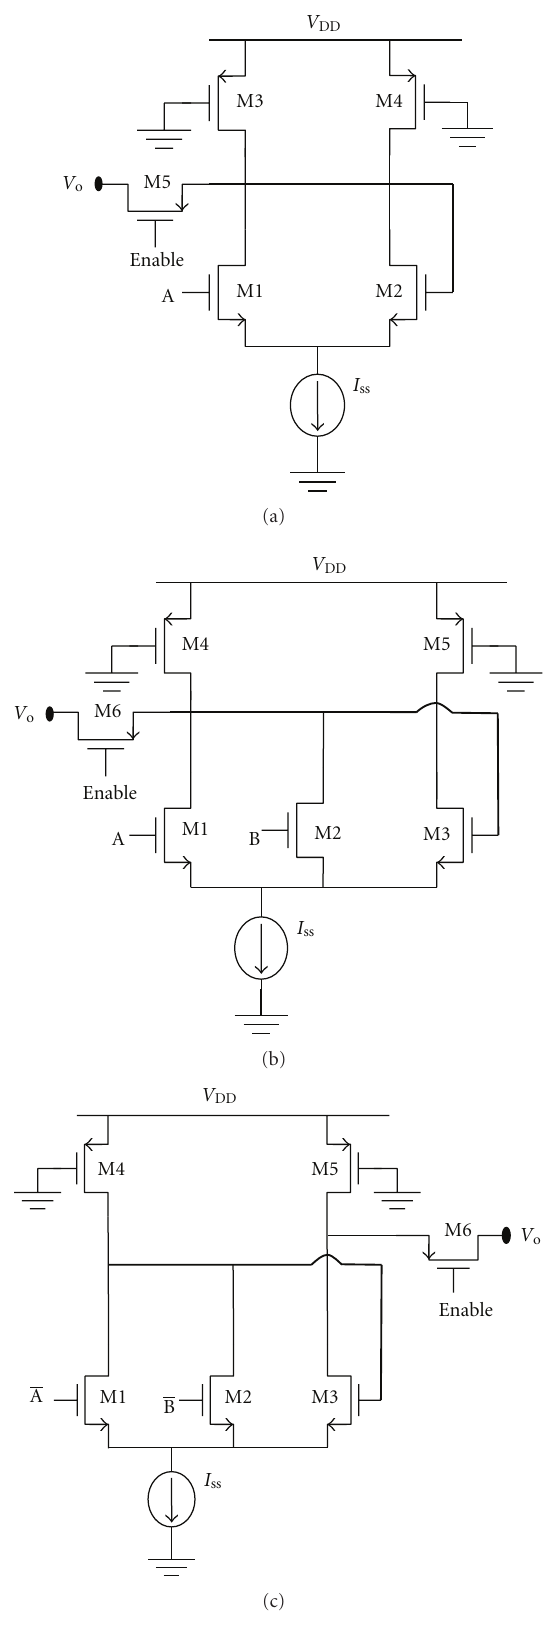
Figure 4: Switch-based PFSCL tristate circuits; (a) bu ff er/inverter (b) 2-input NOR, (c) 2-input